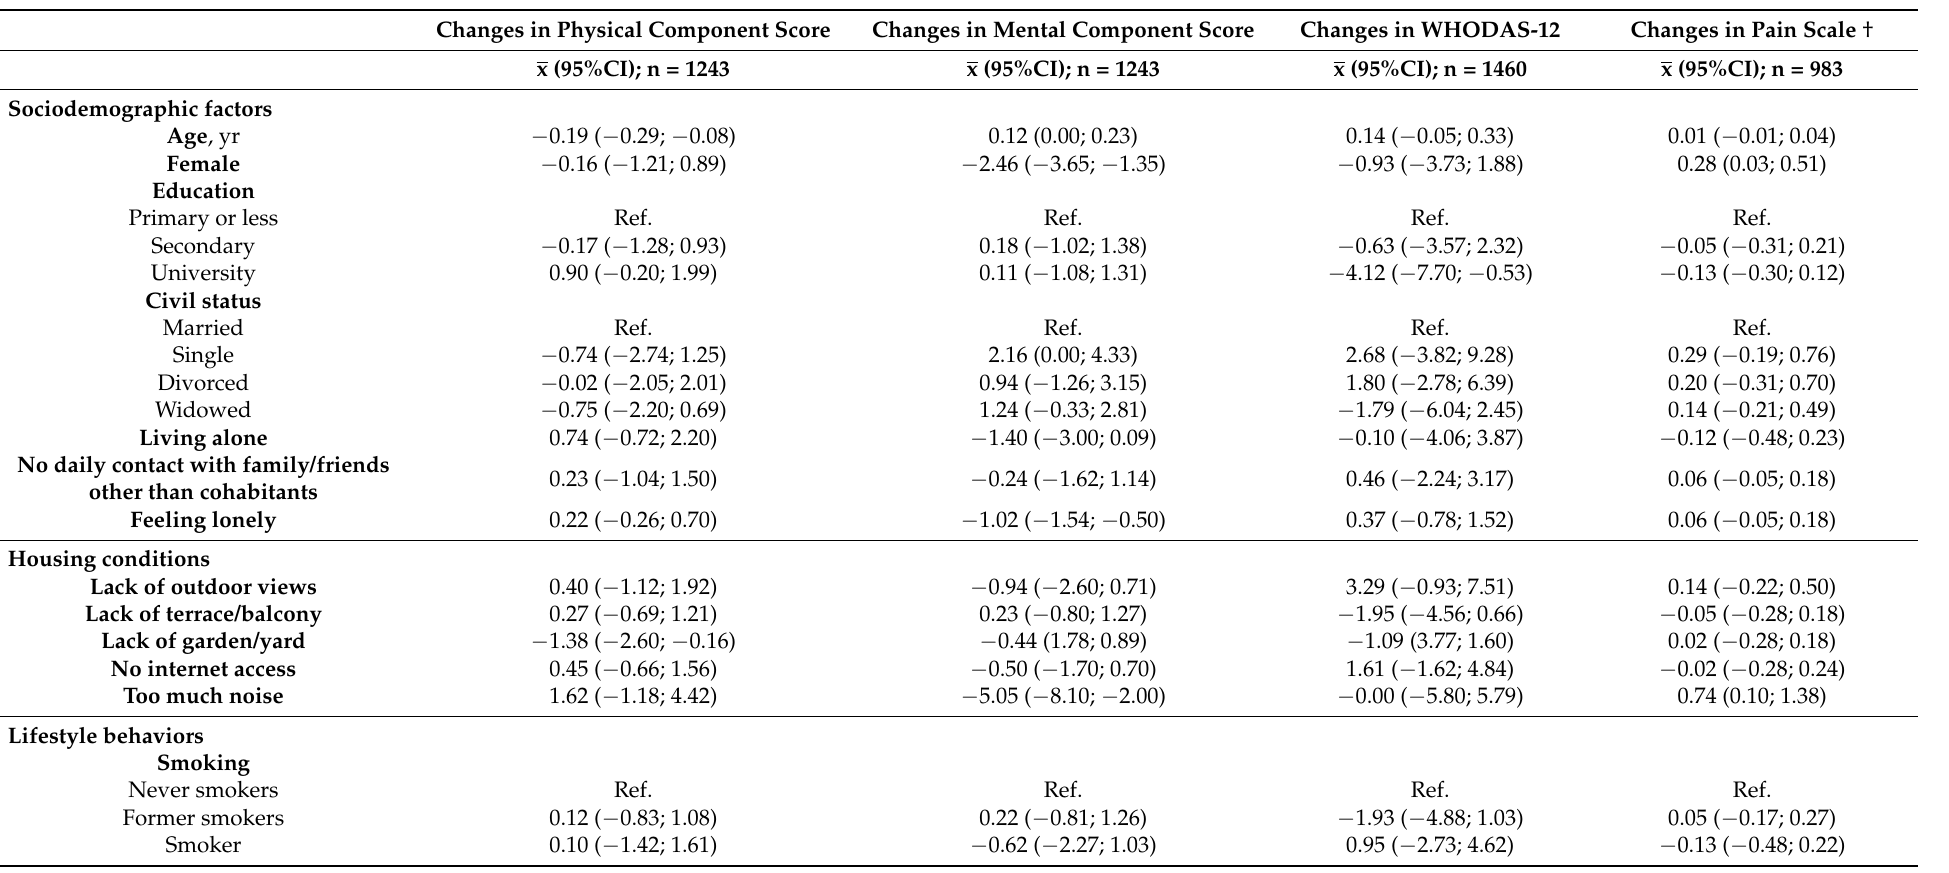
Table 2. Prospective association between participant characteristics and changes in the mental component (MCS) and physical component (PCS) scores of the SF-12 (n = 1243 from Seniors-ENRICA-2), the WHODAS-12 (n = 460 from Edad con Salud), and the pain score (n = 983 from Seniors-ENRICA-2) during the COVID-19 confinement. Increases in MCS or PCS components reflect improvements in health, while increases in the WHODAS-12 or pain scores reflect worsening in health or pain,